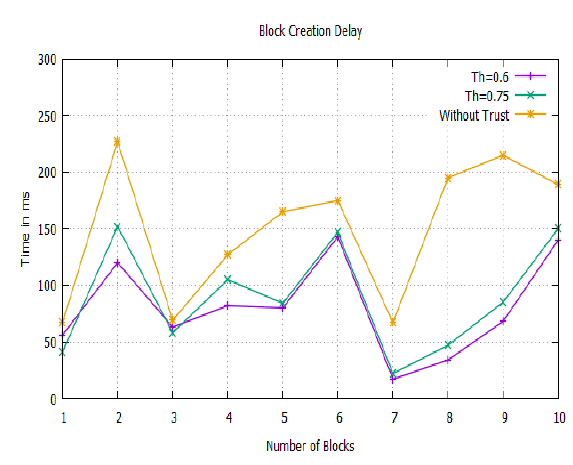
Figure 4.1 Transaction rate